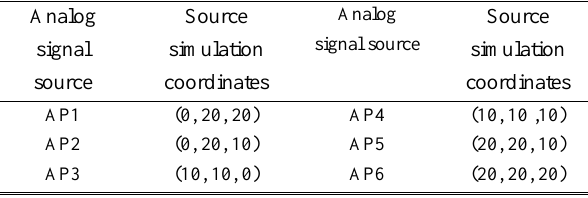
Table 1 Analog Coordinate of Bluetooth